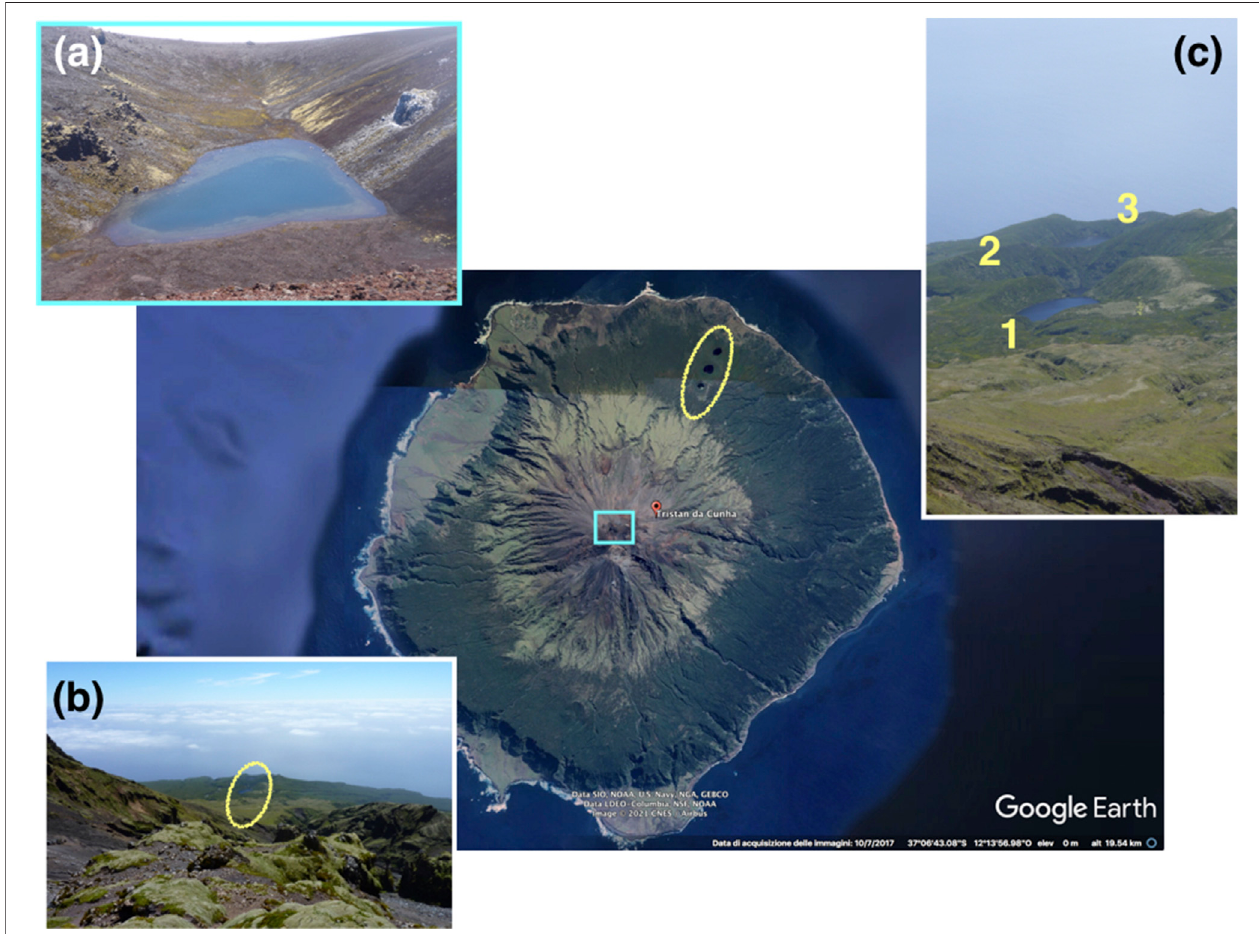
FIGURE8|(A) Theheart-shapedcraterlakeoftheSt.Mary ’ sPeakofTristandaCunha,SouthernAtlanticOcean(turquoisesquareininsetmap); (B) locationofthe alignedmaarsatnorthern fl ankofTristandaCunhaisland(yellowellipseininsetmap); (C) thethreemaarlakes,called “ theponds. ” Note:theyellowpatchestotherightof “ pond 1 ” are lichens, not sulphur remnants of extinct fumaroles (pictures by A. Hicks).